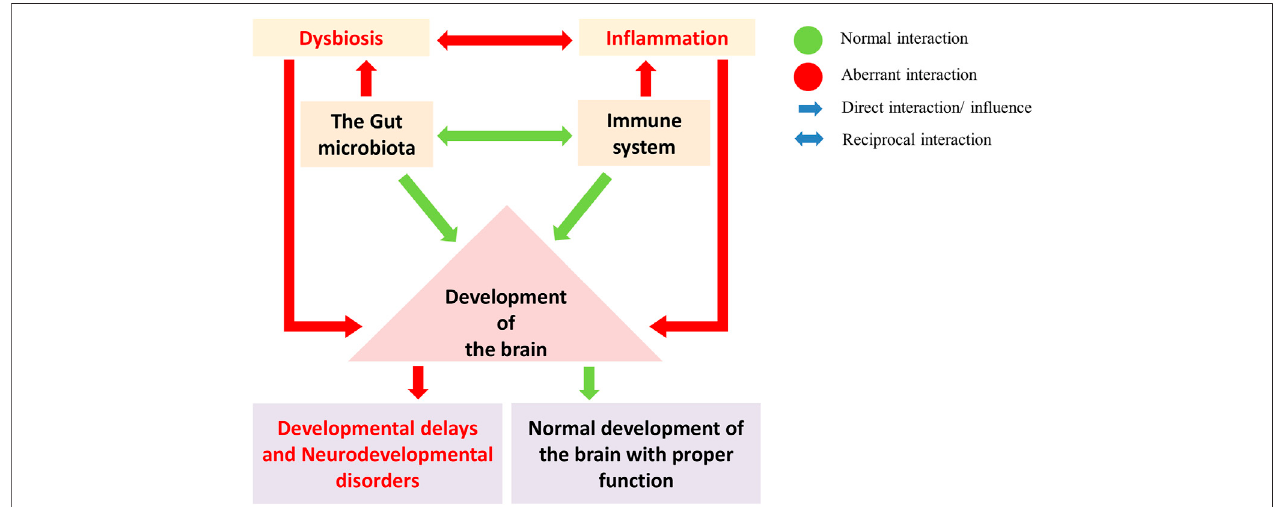
FIGURE 4 | The gut microbes regulate the development and maturation of the immune system and play a crucial role in brain development (Green: normal interaction; Red: aberrant interaction). Gut dysbiosis and the immune system in brain development led to neurodevelopmental disorders. A gut dysbiosis alters the immunesystemhomeostasisandleadstotheactivationofin fl ammatory response.Suchaberration duringbraindevelopmentcandisruptthedevelopmentalpathways, leading to developmental delays and neurodevelopmental